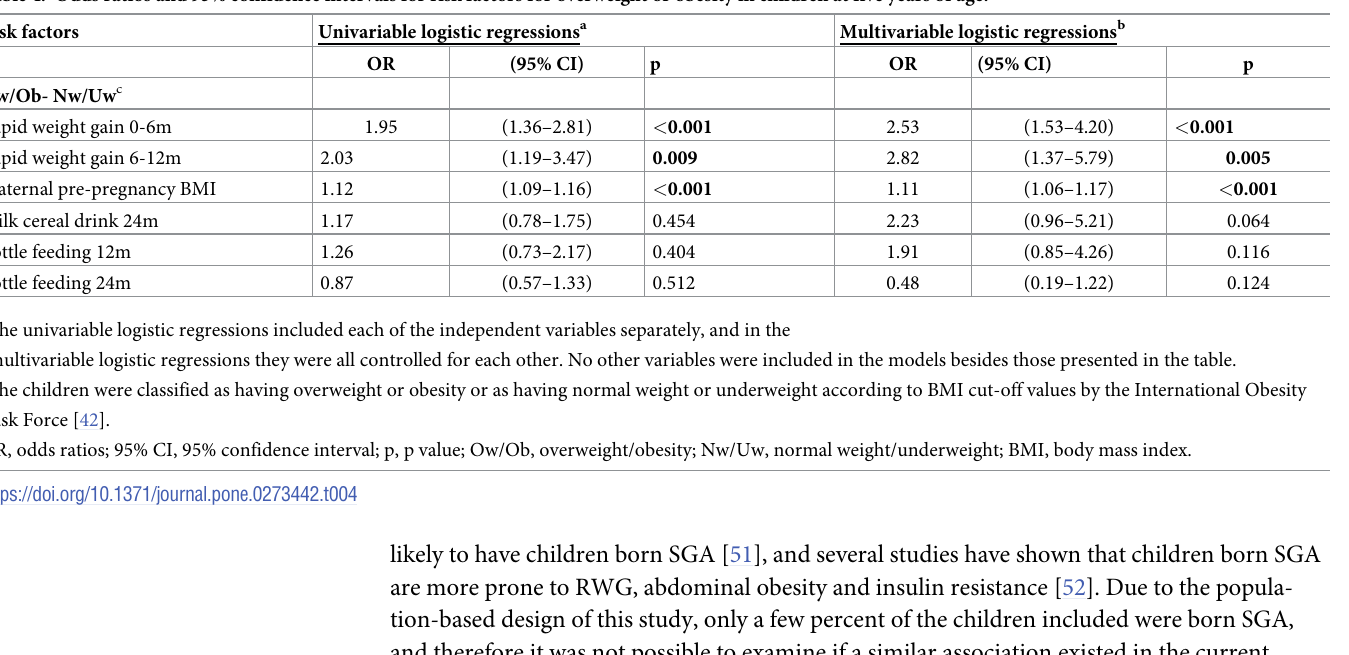
Table 4. Odds ratios and 95% confidence intervals for risk factors for overweight or obesity in children at five years of